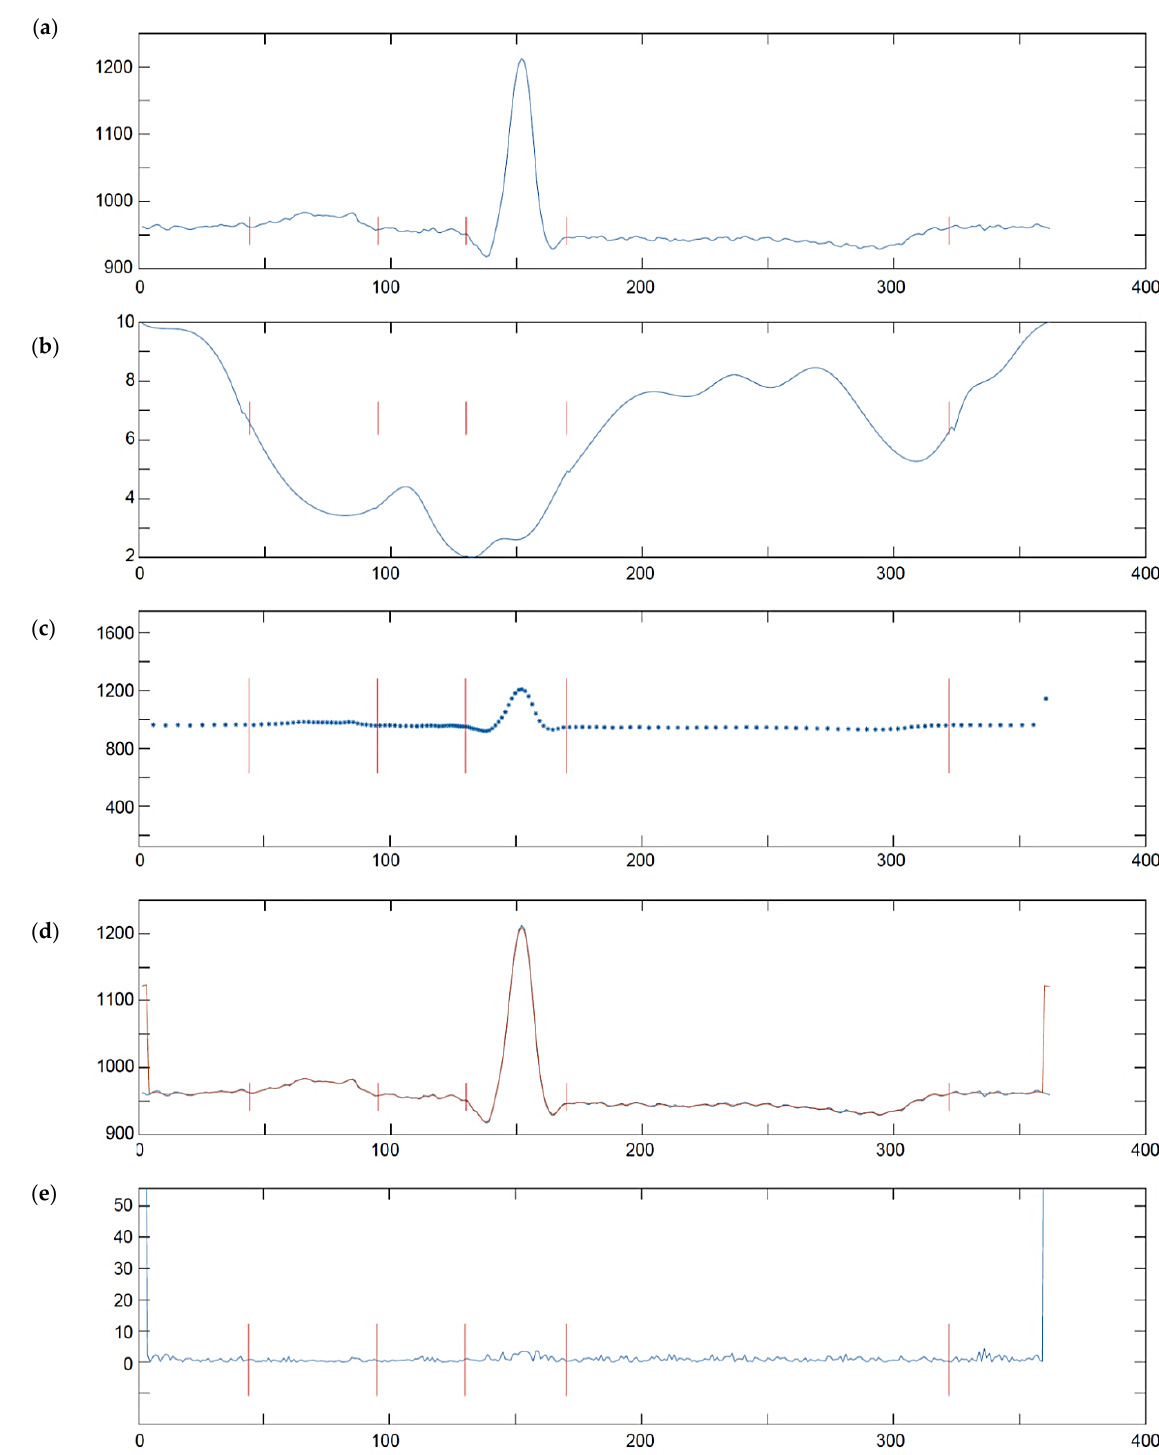
Figure 9. MITDB Database test record 100, lead II ( a ) oECG, ( b ) sampling interval [ms], ( c ) nECG, (dot-plotted to highlight non-uniform sampling), ( d ) uECG (orange) vs. oECG (blue), ( e ) absolute uniformization error (|oECG-uECG|); all horizontal axes in sample numbers (a 2 ms unit); vertical red lines are P, QRS and T-waves delimitation points; errors at both ends of nECG and uECG are caused by adaptive anti-aliasing filter.